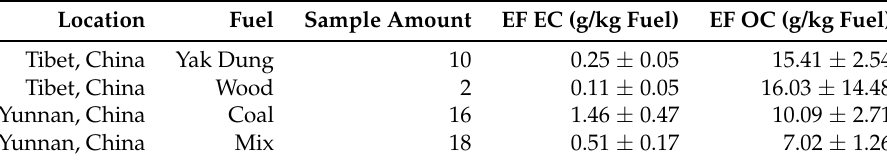
Table 5. Summary of elemental carbon and organic carbon results.